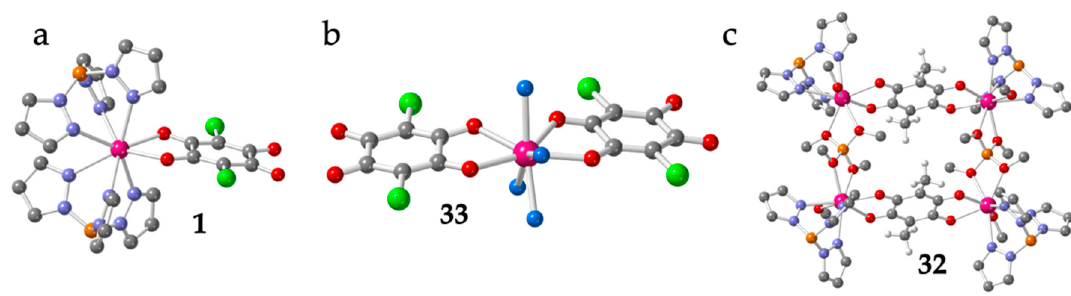
Figure 1. Structure of the only two known Ln ‐ anilato monomers: 1 ( a ) and 33 ( b ). Structure of the unique reported Ln ‐ anilato tetramer, 32 ( c ). Colour code: Ln = pink, Cl = green, C = grey, O = red, B = orange, N = blue and H = white. H atoms are omitted for clarity (except in the CH 3 groups in ( c )). Compounds [Ln 2 (C 6 O 4 H 2 )(thf) 6 Cl 4 ] with Ln = Dy ( 2 ) and Y ( 3 ) [21] constitute two unusual dimers. They are isostructural and contain a bis ‐ bidentate bridging dhbq 2 − ligand (X = H) connecting the two Ln(III) ions. Each Ln ion completes its unusual pentagonal bipyramidal coordination geometry with two Cl and three thf coligands (Figure 2a).